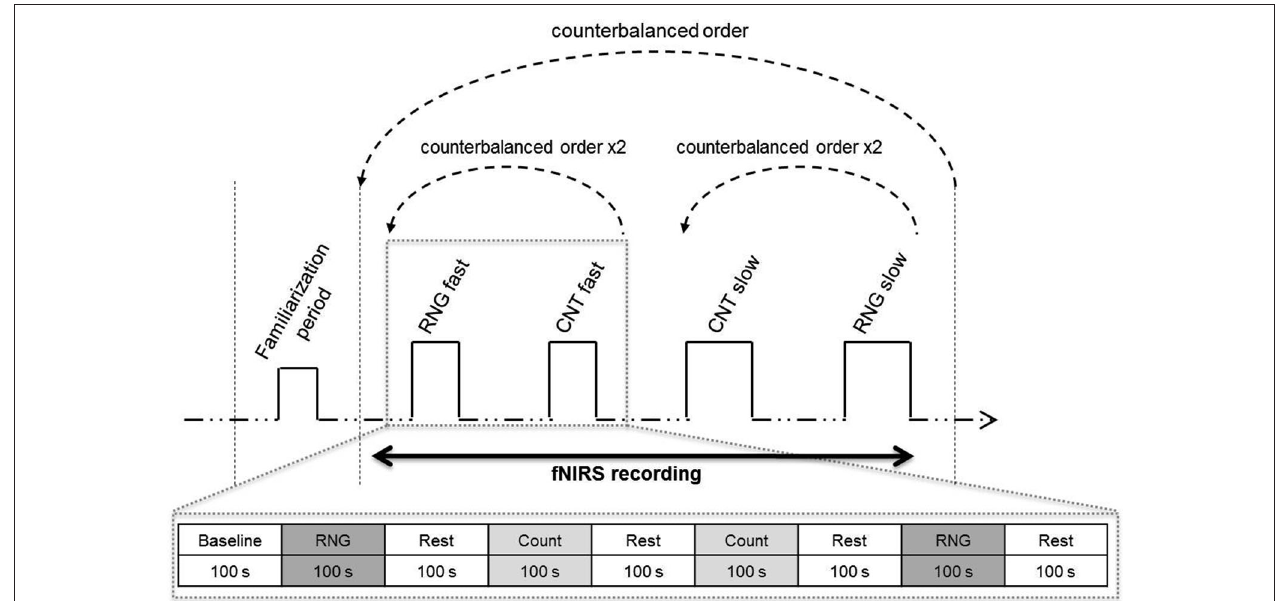
the entire protocol using functional near-infrared spectroscopy (fNIRS). Lower: illustration of the fast pace condition. The participants performed two RNG trials alternating with rest periods and count trials in an ABBA vs. BAAB (A = RNG; B = CNT) counterbalanced order across the participants.